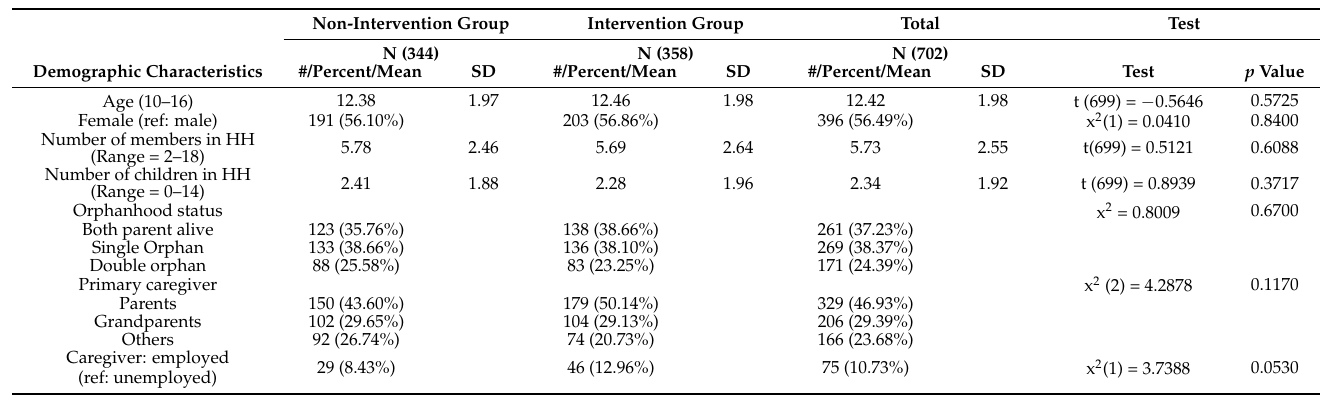
Table 2. Sample Demographics at Baseline.